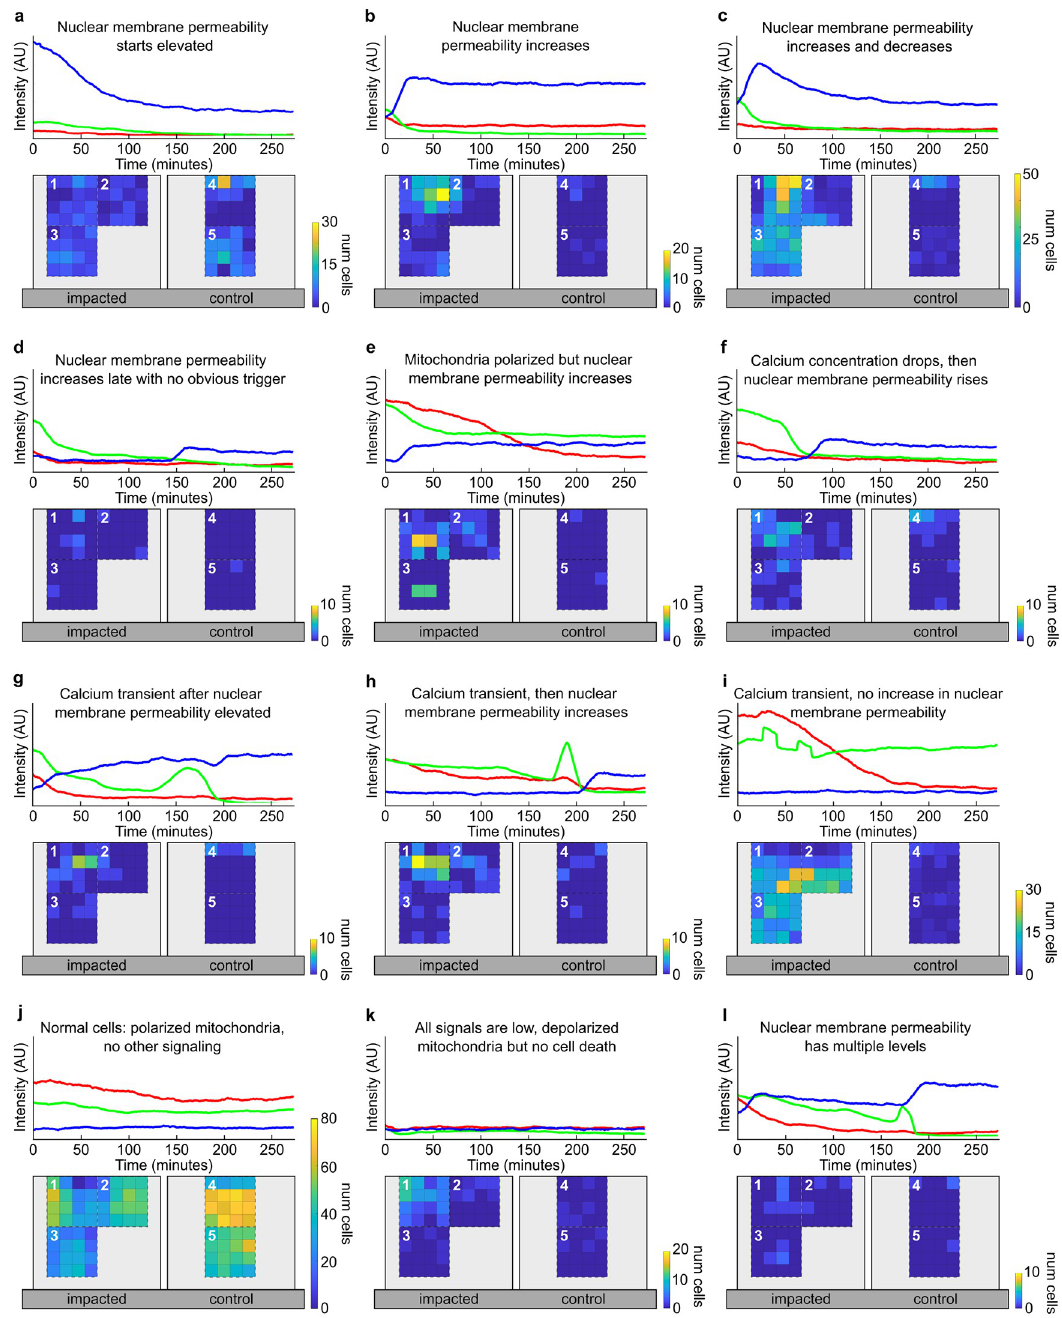
Fig 4. Cell behavior categories and their distributions. For each category, a representative time series for a single cell (top, with blue representing nuclear membrane permeability, green representing calcium concentration, and red representing mitochondrial polarity) along with a heat map of cell counts indicating relative frequency at different locations are shown. Colorbar maxima vary between categories to resolve spatial distributions for categories with fewer cells. Regions 1–3 are on the impacted sample, with 1 as the site of impact. Regions 4–5 are on the control sample. a) The nuclear membrane permeability starts out elevated and decays. b) The nuclear membrane permeability increases within 30 min of impact and plateaus or continues increasing. c) The nuclear membrane permeability increases within 30 min of impact and then decays. d) The nuclear membrane permeability increases after 30 min after impact but no prior signaling event is observed. e) The nuclear membrane permeability increases despite the mitochondria being polarized. f) The nuclear membrane permeability increases after the calcium concentration drops after a period of sustained elevation. g) Transient calcium signaling is observed after the nuclear membrane permeability has already increased. h) The nuclear membrane permeability increases after calcium transient(s). i) Calcium transient(s) are observed with no increase in